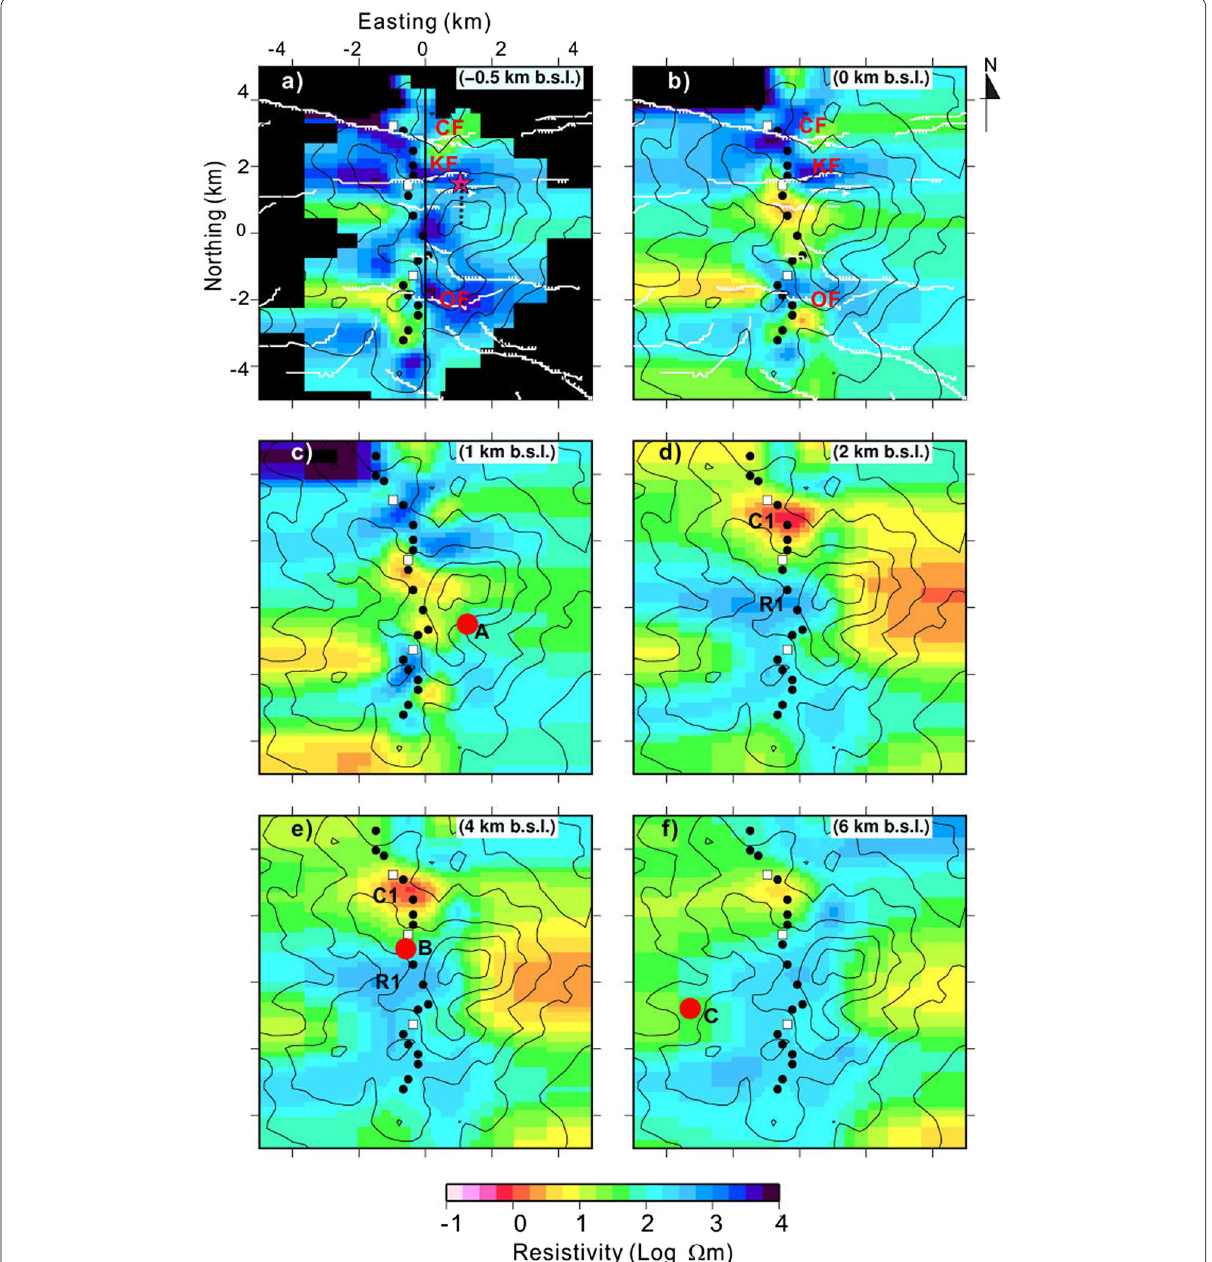
Fig. 4 Horizontal slices of the final 3-D resistivity structure at various depths below sea level (b.s.l). Topographic contour interval is 200 m. Details are as in Fig. 2. The distinctive structures C1 and R1 are labeled. White lines show faults in the survey region ( CF Chijiwa Fault, KF Kusenbu Fault, OF Oshidorino-Ike Fault), while red dots represent pressure sources identified by Kohno et al. (2008). The black line in the center of the top left panel marks the north–south cross section shown in Fig. 5b and 8b. The purple star and dashed black line indicate the USDP-4 drilling location and its subsurface trajectory. Note that the structure away from the profile is not constrained (for example, the sensitivity tests around pressure sources A and C show the small difference in